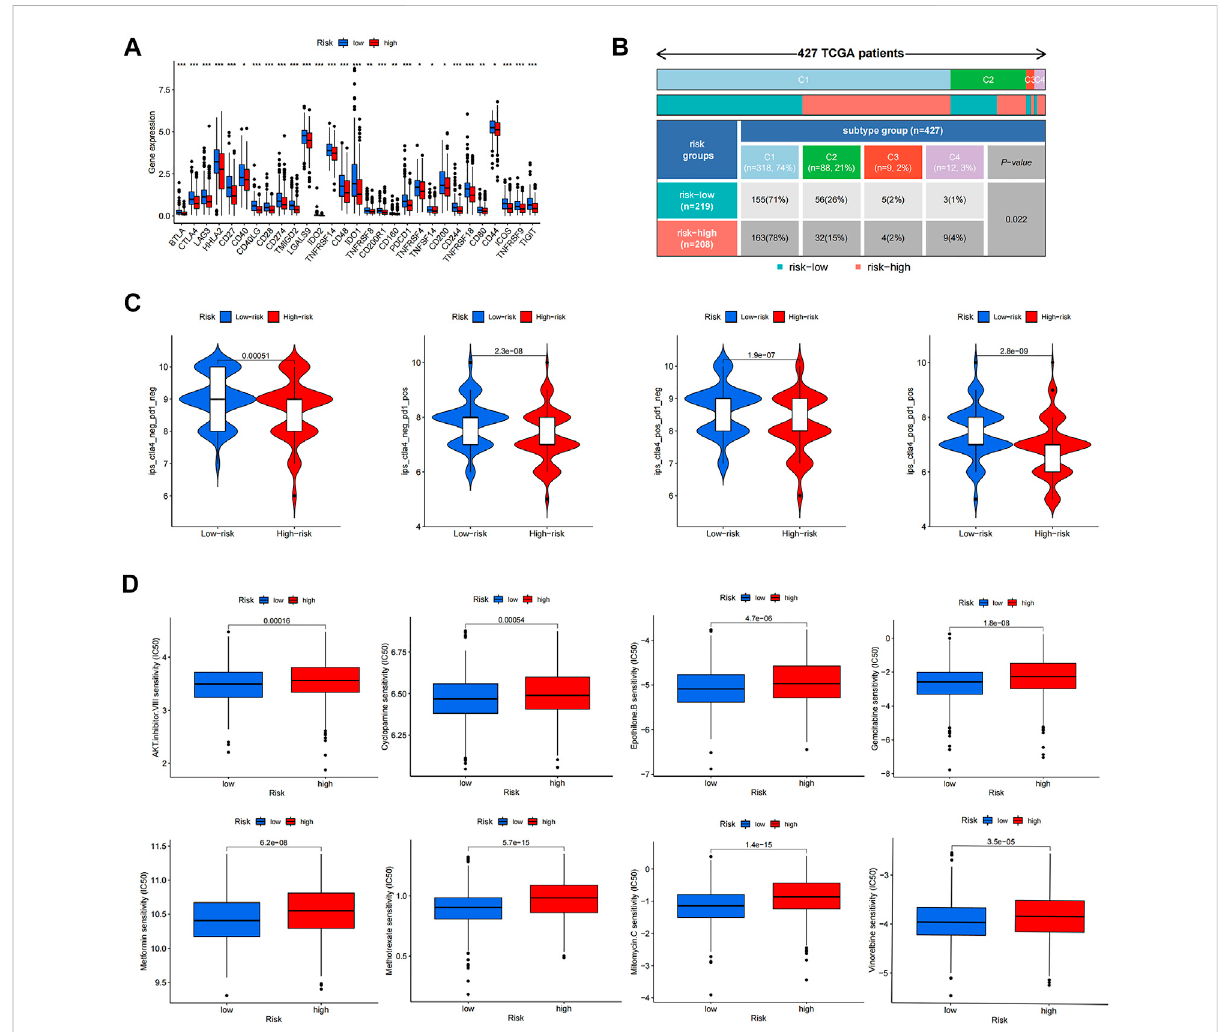
FIGURE 8 Responsetoanti-tumortharapyofcoloncancerpatientsintworiskgroups. (A) Thedifferencesofimmunecheckpointgeneexpressioninhigh- riskand low-risk groups. (B) Heatmapand table showing thedistributionofcolon cancer immune subtypes between two riskgroups. (C) Violin plots showed the relationship between IPSs and risk groups. (D) Eight therapeutic drugs showed signi fi cant IC50 differences. * p < 0.05; ** p < 0.01; and *** p <